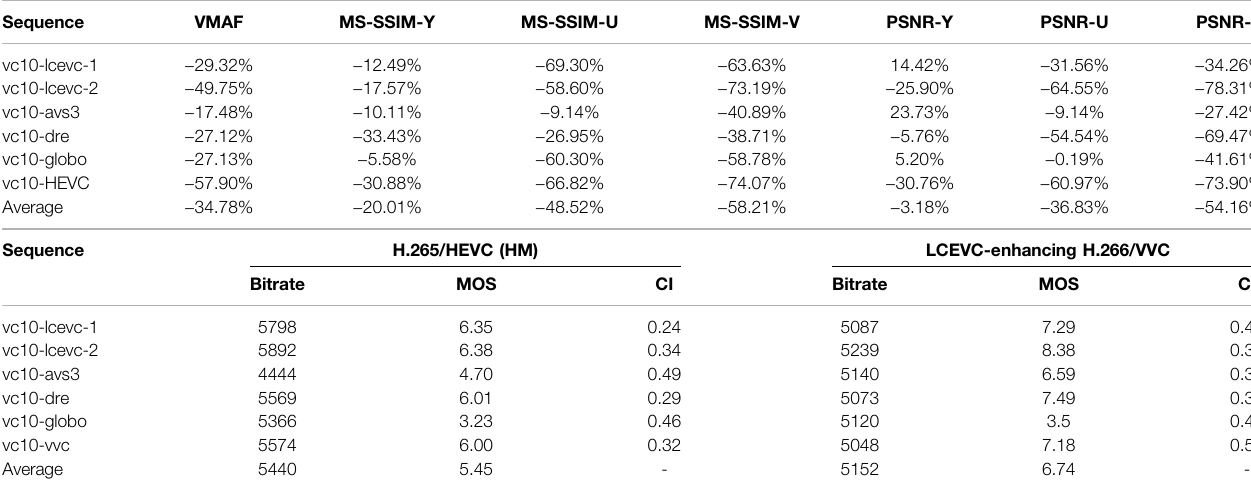
TABLE 5 | BD-rate savings for PQ sequence – Con fi guration A.